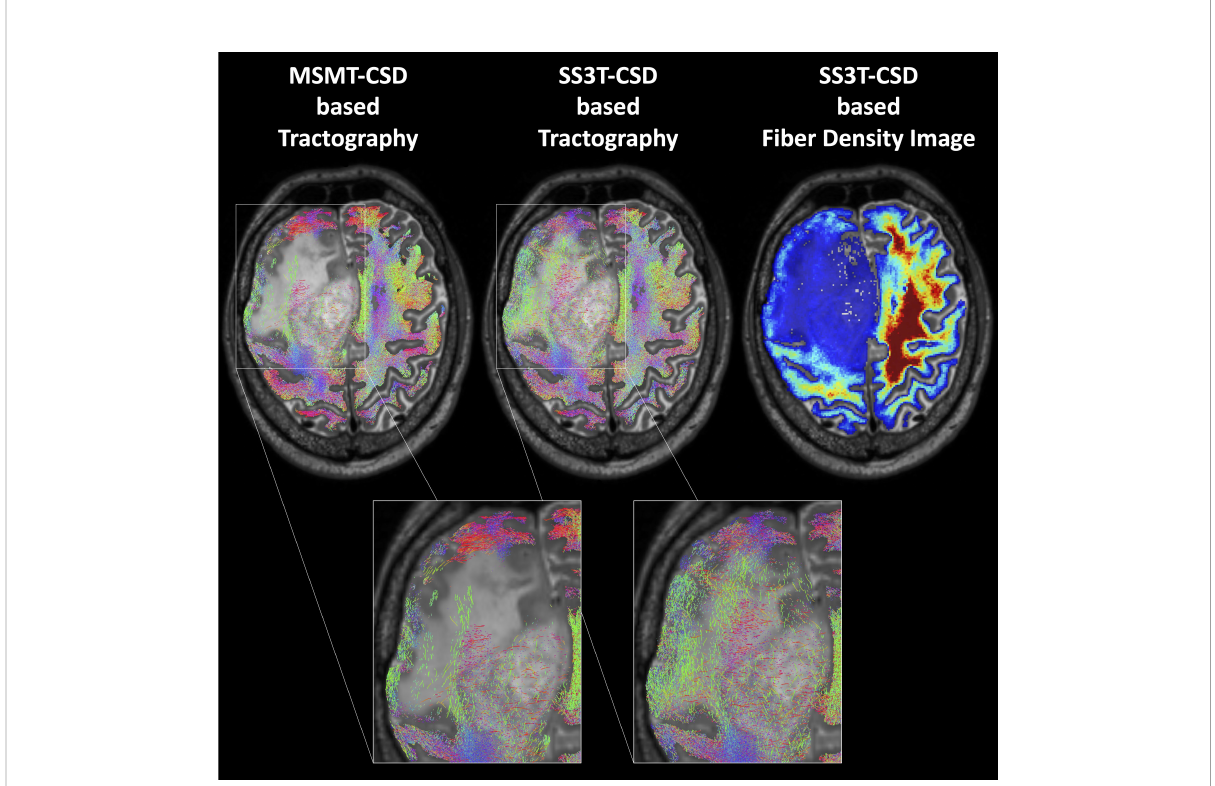
FIGURE 1 Probabilistic whole-brain tractography and fi ber density image in a patient with recurrent glioma and perifocal edema. In normal brain tissue, a method that increases the biological plausibility is applied (Anatomically-Constrained Tractography), while this condition is relaxed in pathologically altered brain regions. In contrast to the standard multi-shell multi-tissue constrained spherical deconvolution (CSD) based tractography of MRtrix3 (MSMT), the advanced MRtrix3tissue method using the single-shell 3-tissue CSD algorithm (SS3T) detected an adequate number of fi bers also within the tumorous or edematous